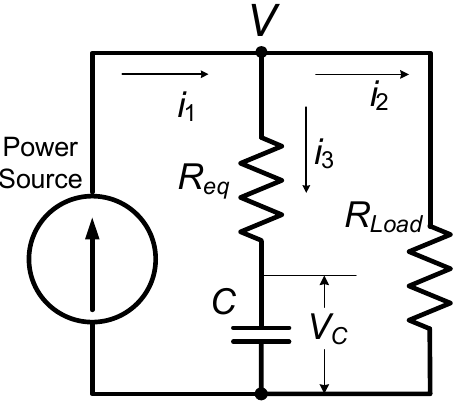
Figure 1. Equivalent circuit of the distributing network.